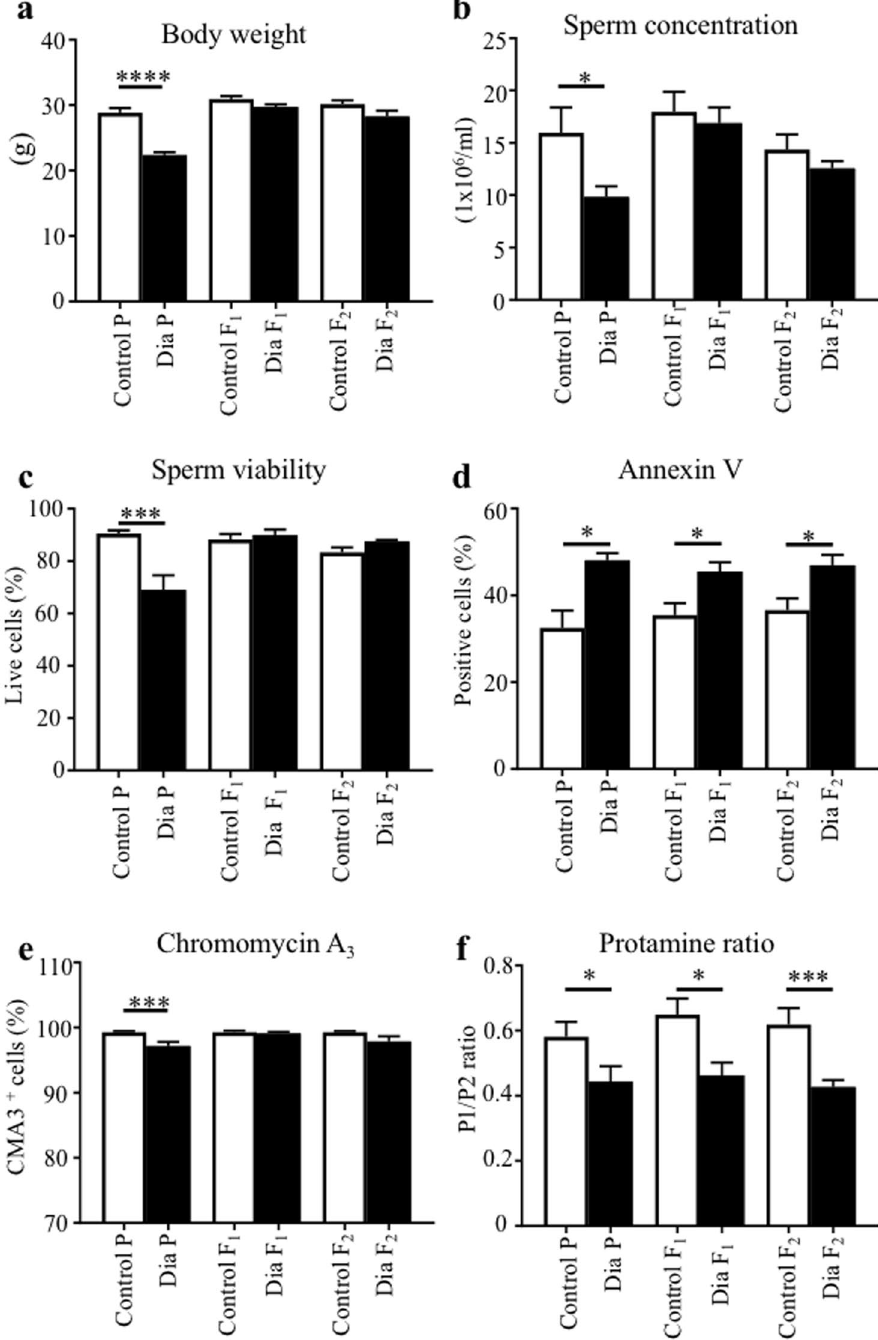
Figure 2. Transgenerational phenotype transmitted from diabetic father (P) through the male germ line. Effects of diabetes on body weight ( a ), sperm concentration ( b ), sperm viability ( c ), the level of apoptotic marker annexin V ( d ), percentage of chromomycin A 3 positivity for chromatin packaging evaluation ( e ), and ( f ) protamine ratios were determined in caudal epididymal sperms from diabetic and control non-diabetic males (P) and from subsequent F 1 and F 2 male progeny. Results are expressed as the mean ± SEM (Control P = 14, Dia P = 13, Control